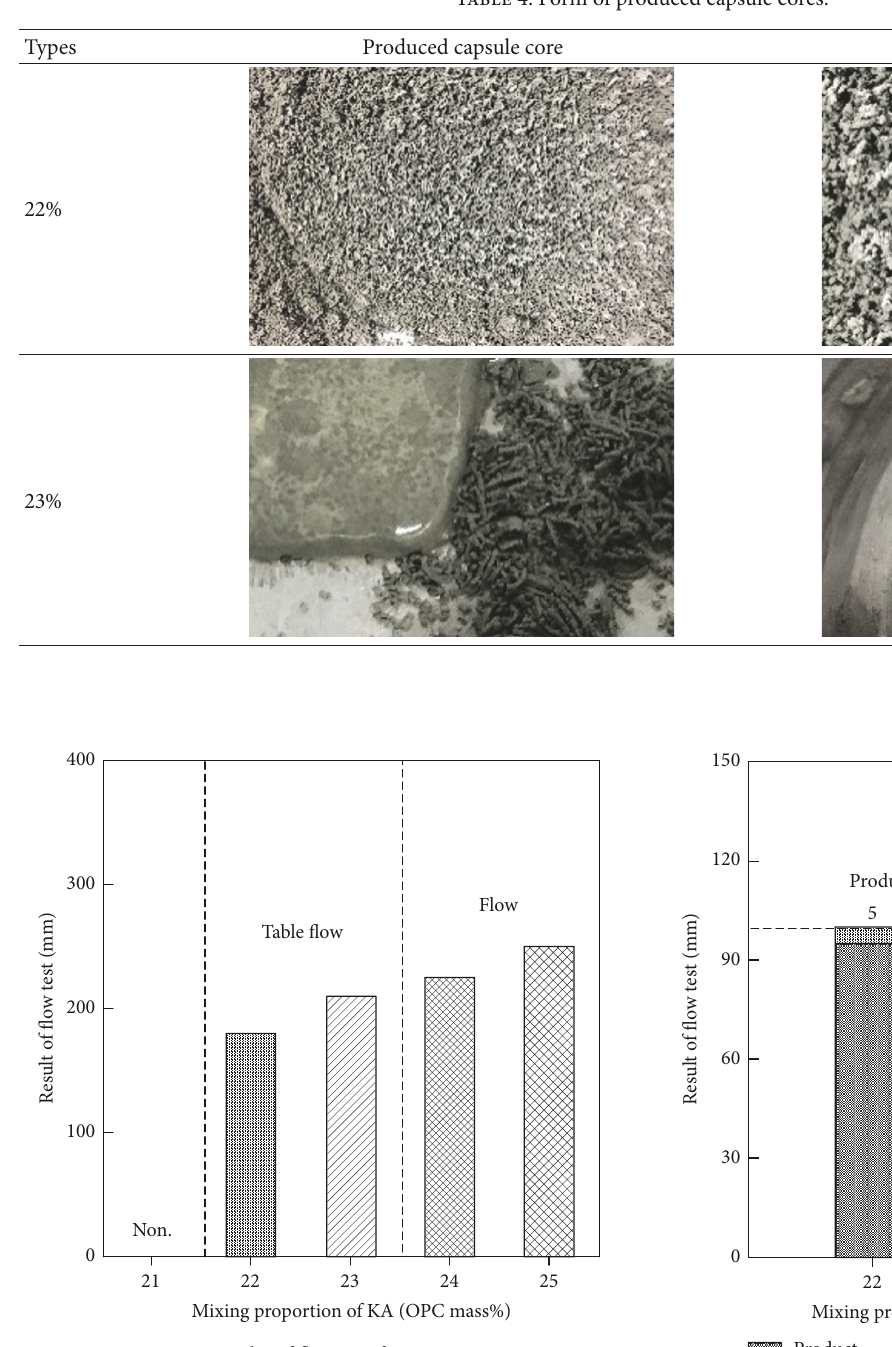
Figure 5: Results of flow test for Step 2 group.